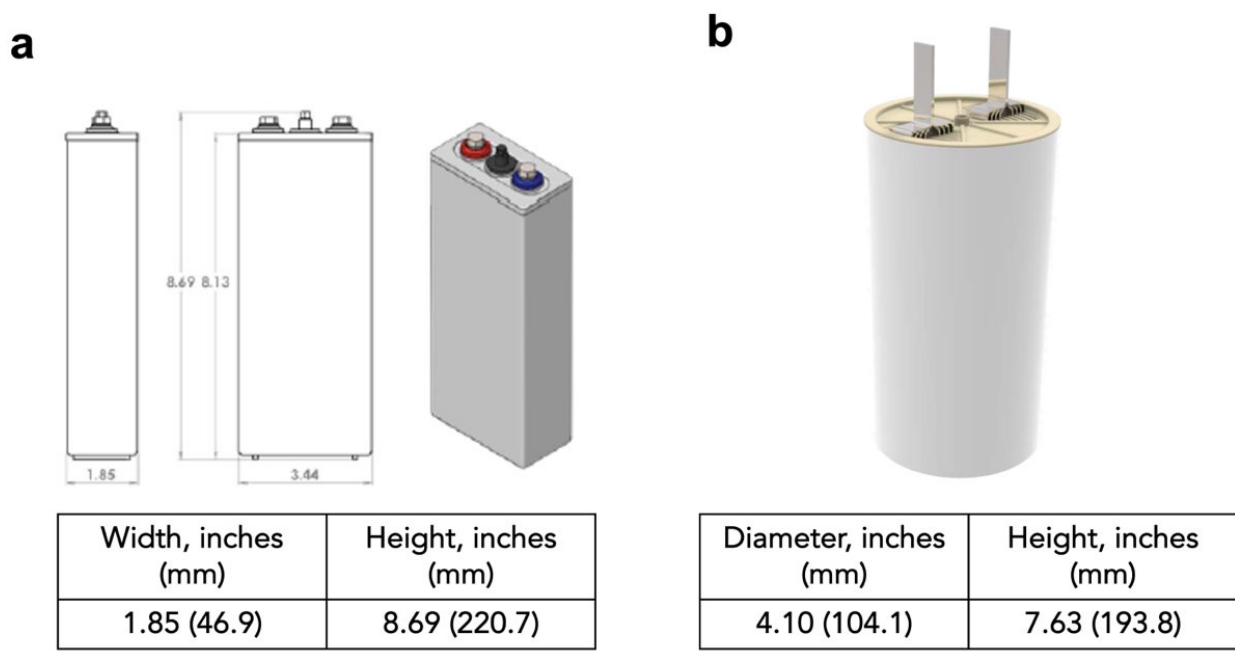
Figure 2. ( a ) Commercially made 19 Ah prismatic cell. ( b ) Commercially made 70 Ah cylindrical cell.